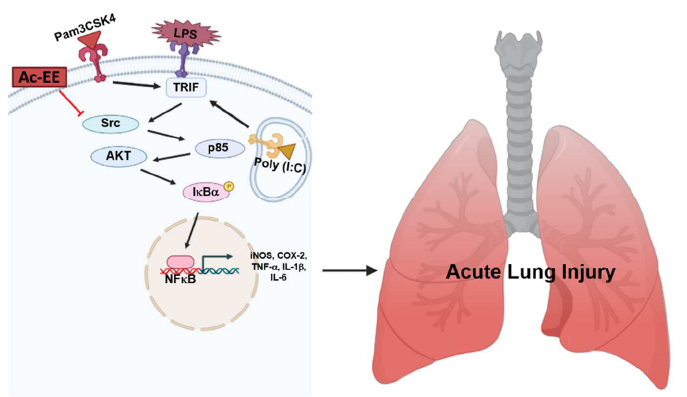
Figure 5. The potential inhibitory pathway of Ac-EE-mediated anti-lung injury activities.